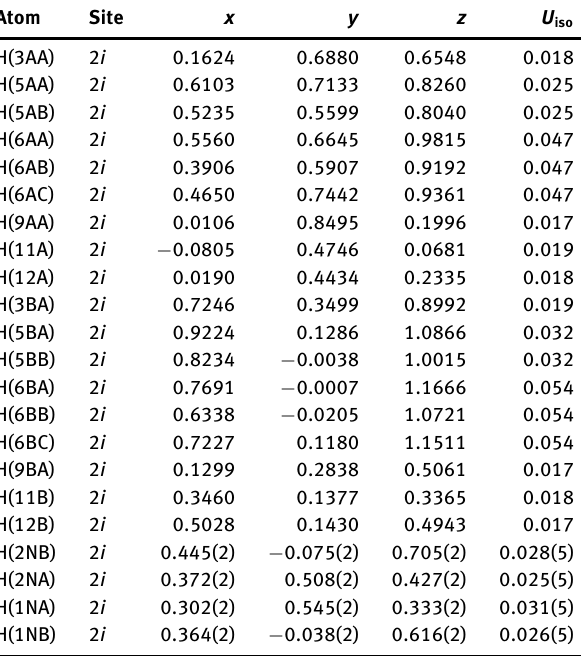
Table 2: Fractional atomic coordinates and isotropic or equivalent isotropic displacement parameters (Å 2